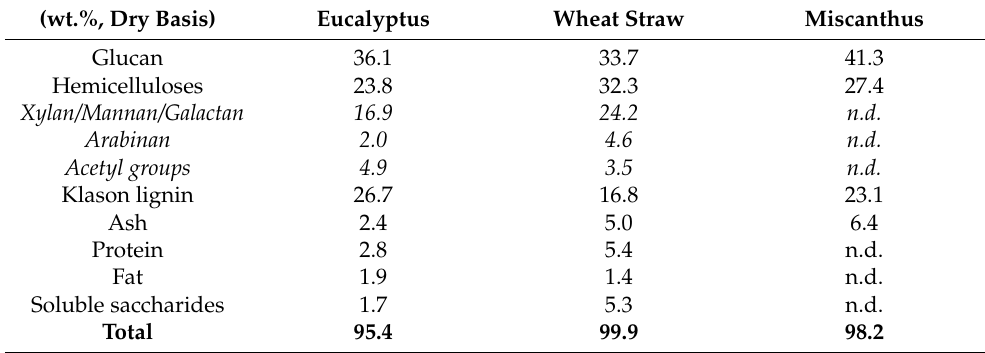
Table 1. Composition of starting